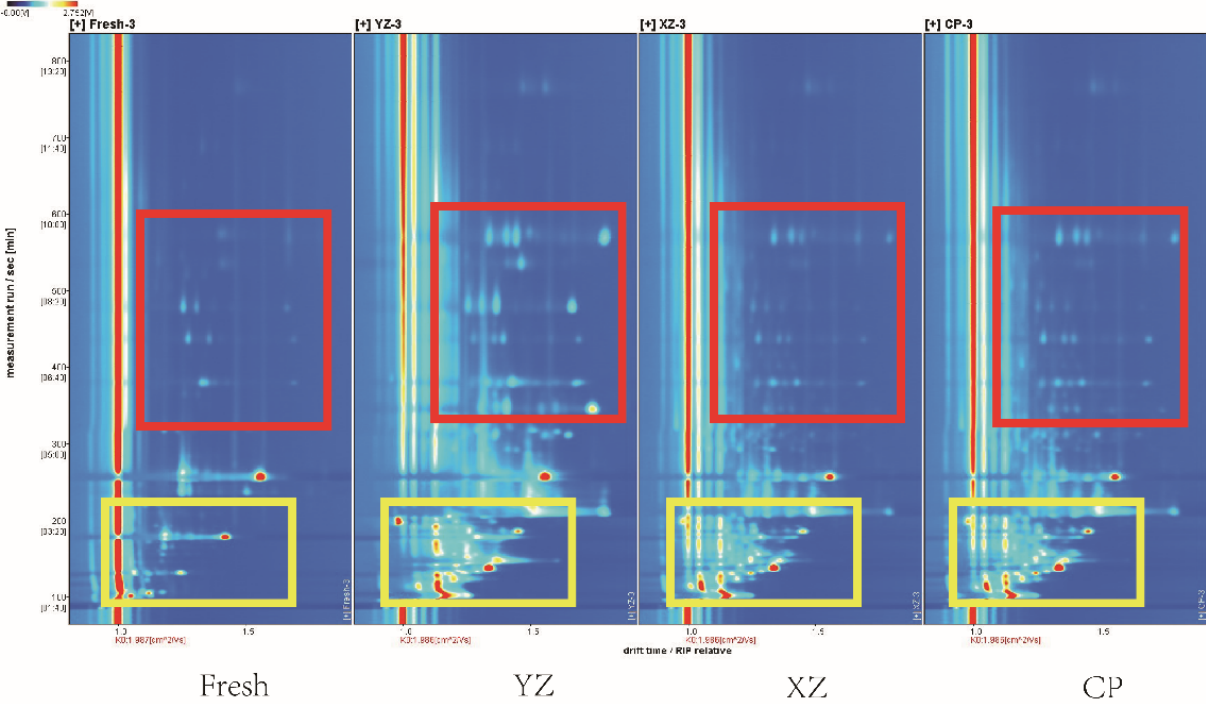
Figure 2. The gallery plots of VOCs from different stages using CC–IMS. Fresh: raw sample; YZ: cured sample; XZ: smoking sample; CP: finished sample; VOCs: volatile organic compounds.